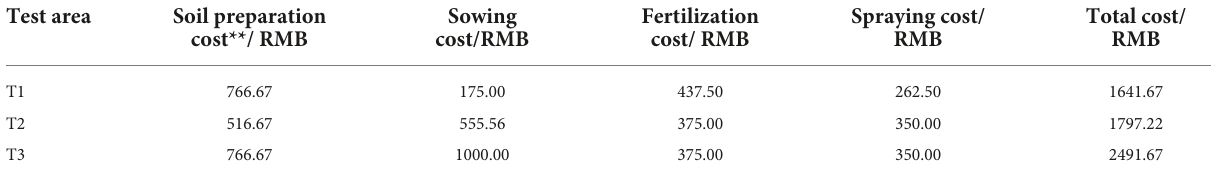
TABLE 5 Labor cost of soil preparation, sowing, fertilizing, and spraying in different experimental areas*. Test